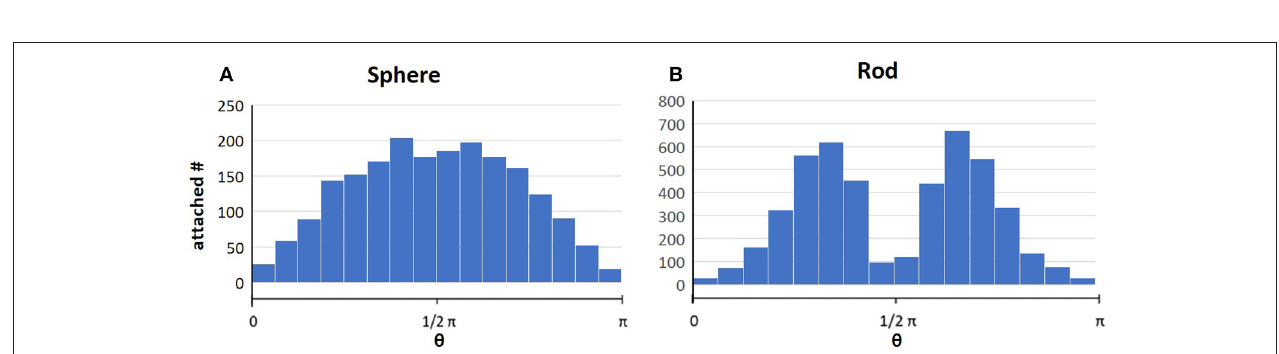
FIGURE 7 | Simulated attachment orientations in terms of Euler angle θ for polystyrene spheres (A) and rods (B) (1 µ m in equivalent volume diameter) in parallel plate geometry under pore water velocity of 5 m/day with flow direction perpendicular to gravity. Other simulation conditions were identical as those for Figure 3 .